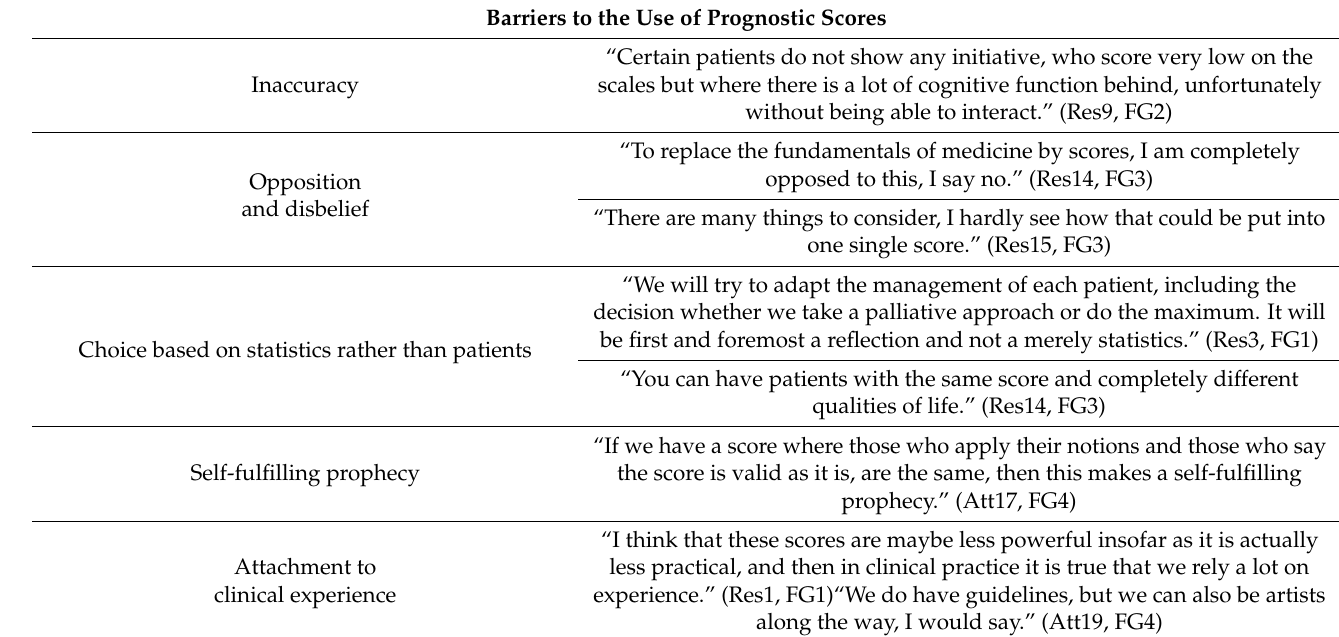
Table 3. Barriers to the use of prognostic